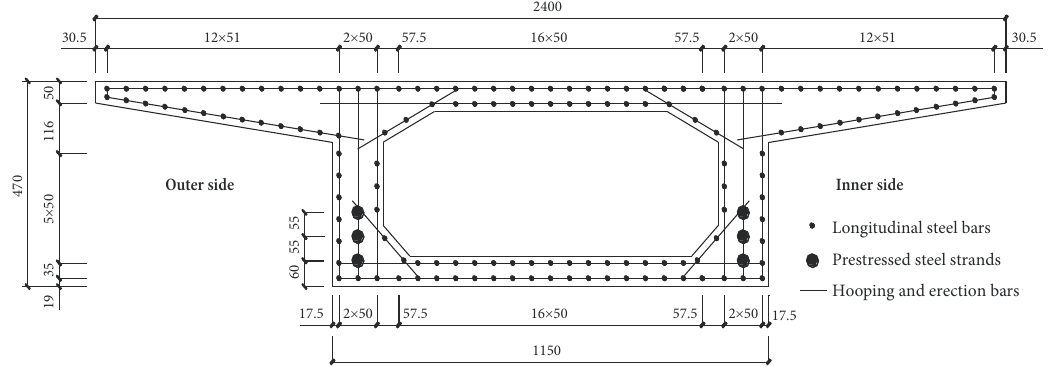
Figure 2. The layout of steel bars in the box girder model (Unit: mm)